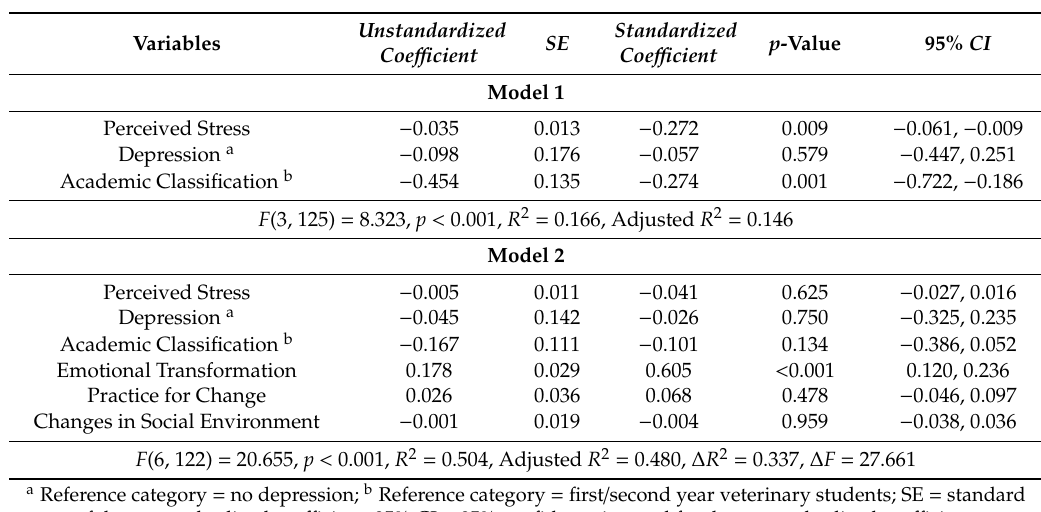
Table 4. Hierarchical Multiple Regression Predicting Sustenance for Intentional Relaxation Behavior ( N =